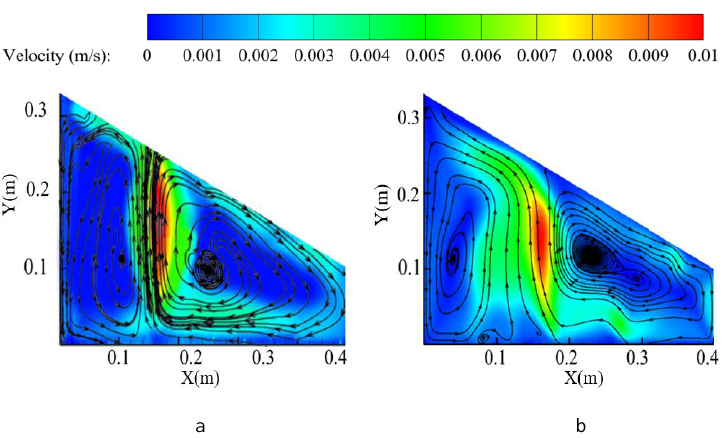
Figure 8. Cross-sectional velocity contour in the middle of the geometry (0.2 m, AR = 2.6, θ = 30°, Ra s = 1.38 × 108), ( a ) experiment, ( b ) CFD simulation.